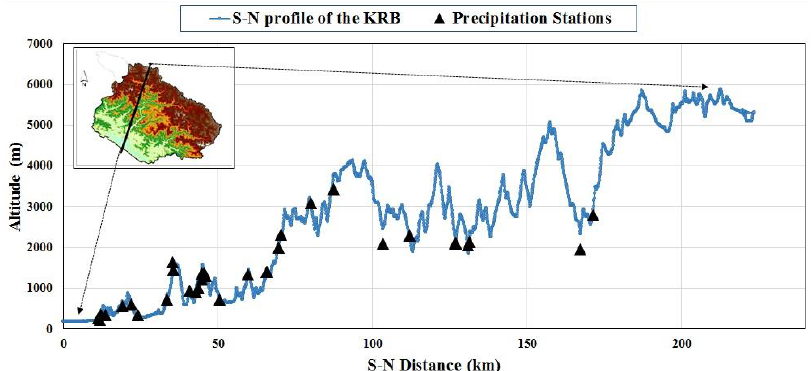
Figure 2. South-North gradient along the transect shown by dark line and the location of stations in the KRB.